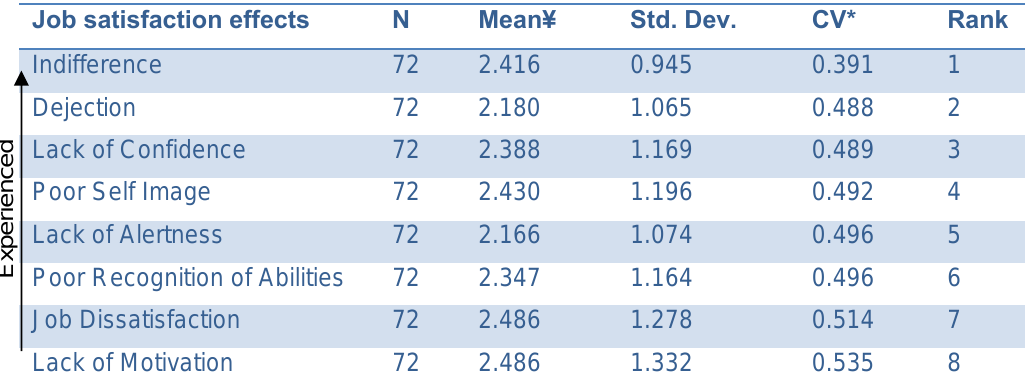
Table 4: Job satisfaction